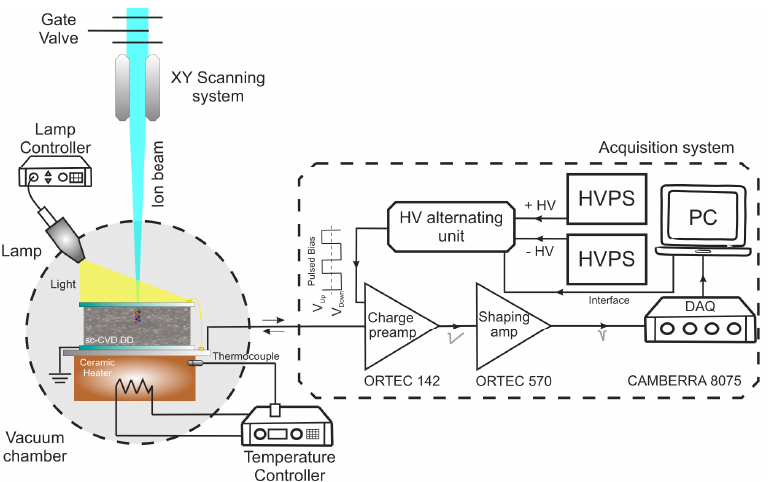
Figure 2. Schematic diagram showing the main components of the experimental setup and the standard spectroscopy acquisition chain. standard spectroscopy acquisition